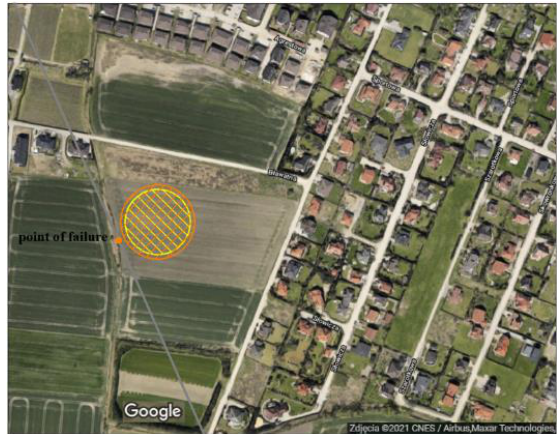
Figure 24. Hazard zones due to an explosion for a natural gas pipeline (a = 0.2, L = 50 m): yellow zone, p = 1 MPa; orange zone, p = 5 MPa.